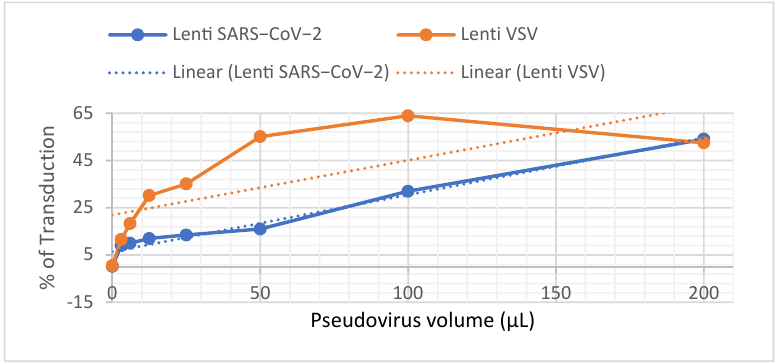
Figure 4. Titration of LV spike SARS-CoV-2 and LV VSV on HEK293-ACE2 cells.